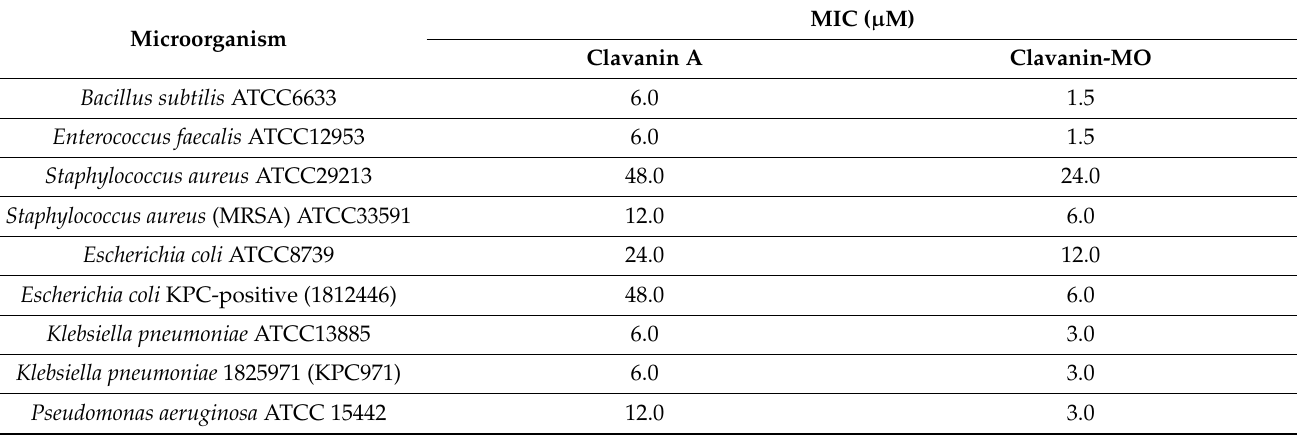
Table 1. Antibacterial activity of clavanin A and the synthetic peptide clavanin-MO. Adapted from ref.